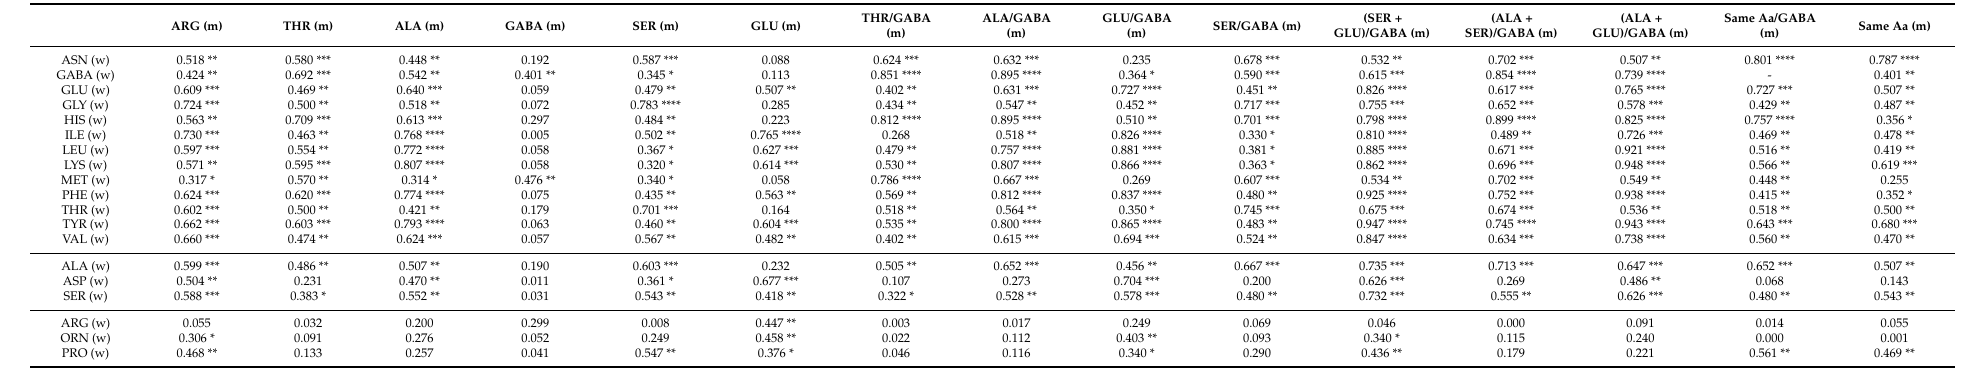
Table 3. Table of correlations between the amino acids (Aa) in wine (w) and the most concentrated assimilable amino acids of the must (THR, ARG, ALA, GABA, GLU and SER), and particularly to the ratios of some of them with GABA. Data are given as R 2 (Linear least-squares